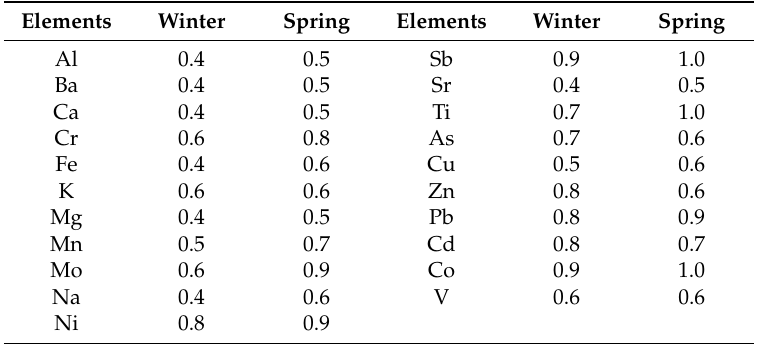
Table A1. Average I/O ratios of elements in indoor and outdoor SSAs’ fractions in winter and spring ( n = 5).